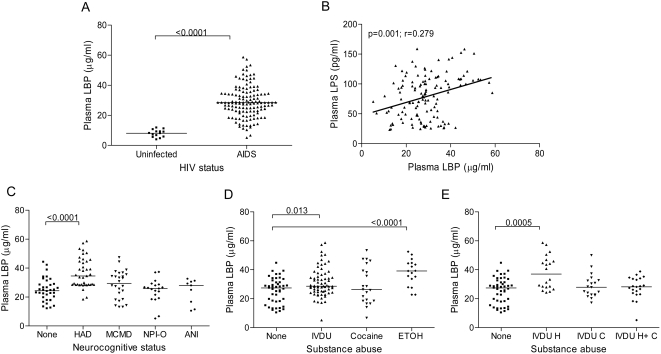
Increased plasma lipopolysaccharide binding protein (LBP) levels in AIDS patients with HAD.(A) LBP levels were quantified in plasma from AIDS patients (n = 119) and uninfected controls (n = 14) by ELISA. (B) Spearman correlation (r and p-values) was calculated to determine relationships between LBP levels and plasma LPS. (C) LBP levels were compared between AIDS patients classified into 5 groups based on the level of NCI as in Figure 1C or (D–E) classified into groups based on patterns of substance abuse as in Figure 2A–B. Median values are indicated as horizontal lines and statistical significance between groups was calculated using the Mann-Whitney test; significant differences (p<0.05) are indicated.